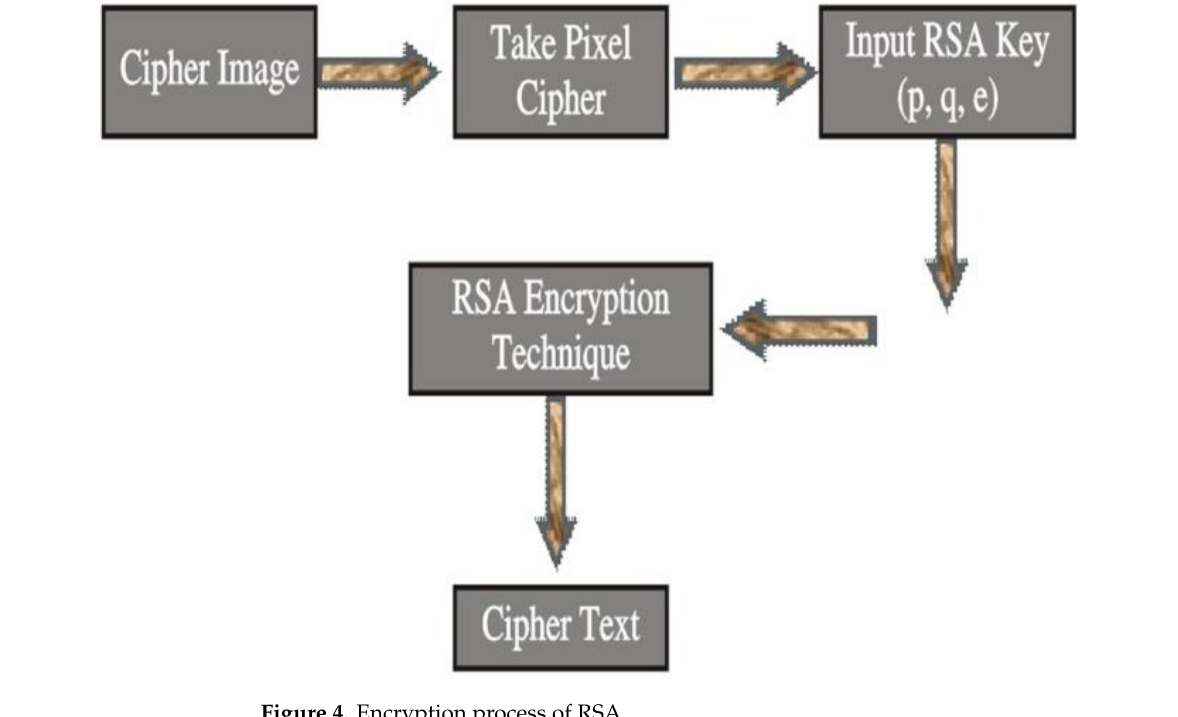
Mathematics 2022 , 10 , x FOR PEER REVIEW